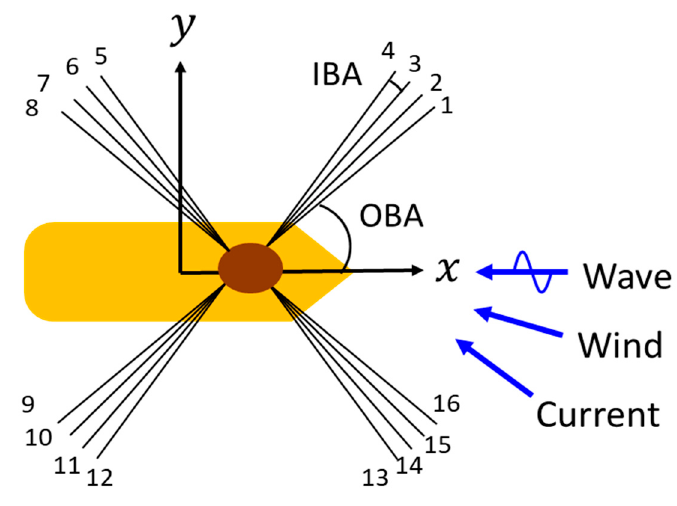
Figure 3. The top view of the target mooring system with environmental direction.